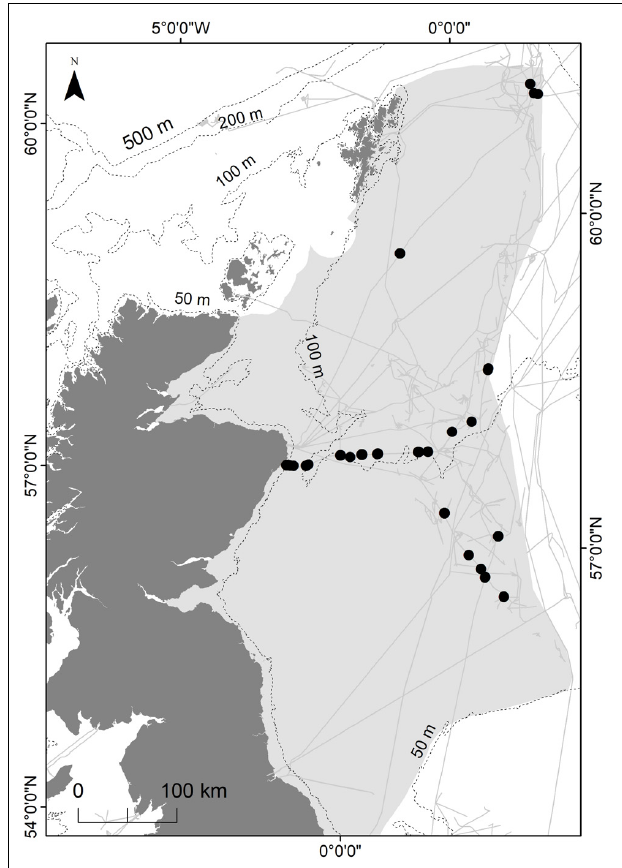
FIGURE 1 | Oil and gas pipelines (gray lines) in the northern North Sea region (shaded area). Black circles represent the location samples of ROV footages used in this